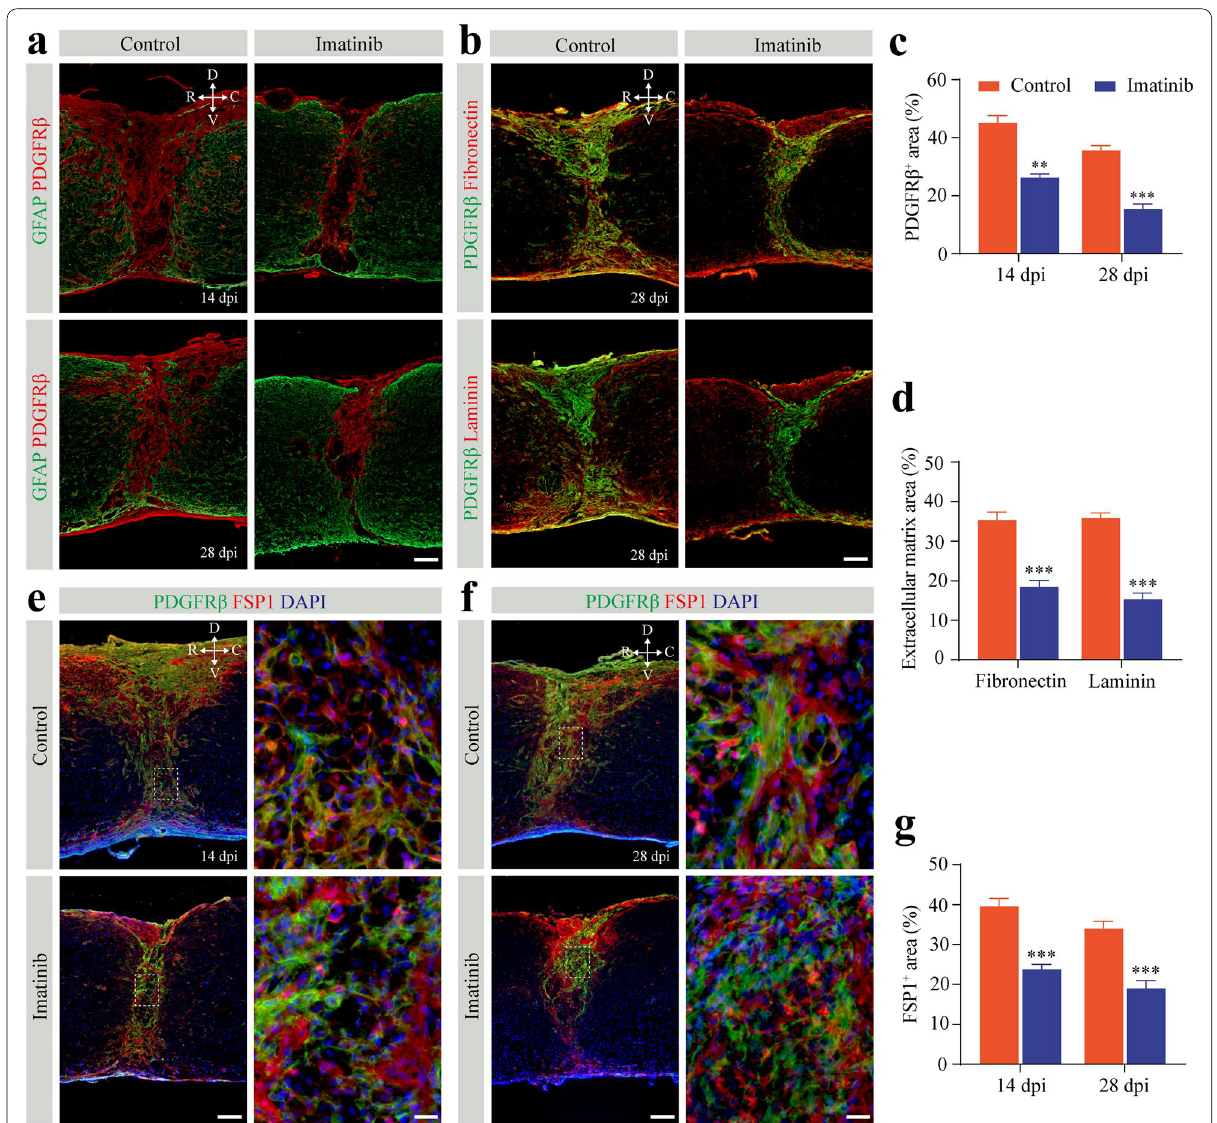
Fig. 7 Pharmacologically inhibiting the PDGF‑BB/PDGFRβ signaling pathway reduces fibrotic scarring and fibroblasts after SCI. a Representative immunofluorescence images of GFAP (green) and PDGFRβ (red) in mice treated with imatinib or PBS (control) at 14 and 28 days post‑injury (dpi). b Representative immunofluorescence images of PDGFRβ (green) and extracellular matrix fibronectin (red, upper panel) and laminin (red, lower panel) at 28 dpi. c , d Quantification of fibrotic scar area ( c ) and extracellular matrix area ( d ) in a and b . e , f Representative immunofluorescence images of PDGFRβ (green) and FSP1 (red) in mice treated as described above at 14 dpi ( e ) and 28 dpi ( f ). The nuclei are stained with DAPI (blue). High magnification images of the dotted area in the left panel are shown in the right panel. All images are from sagittal sections. g Quantification of the fibroblast area occupied by FSP1 in e and f . Scale bars: 100 μm ( a , b and left panel in e and f ) and 20 μm (right panel in e and f ). Data are expressed as mean s.e.m. n 4–6 per group. ** p < 0.01 and *** p < 0.001 versus control by unpaired two‑tailed Student’s t test in c , d , ± = and